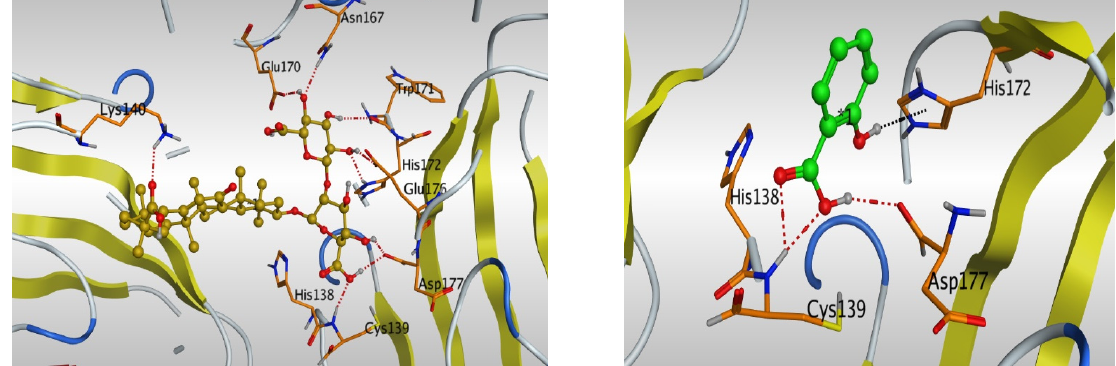
Figure 1. 2D and 3D representation of docking of compounds: glycyrrhizic acid and salicylic acid into the central binding site of leaf roll viral protein coat.